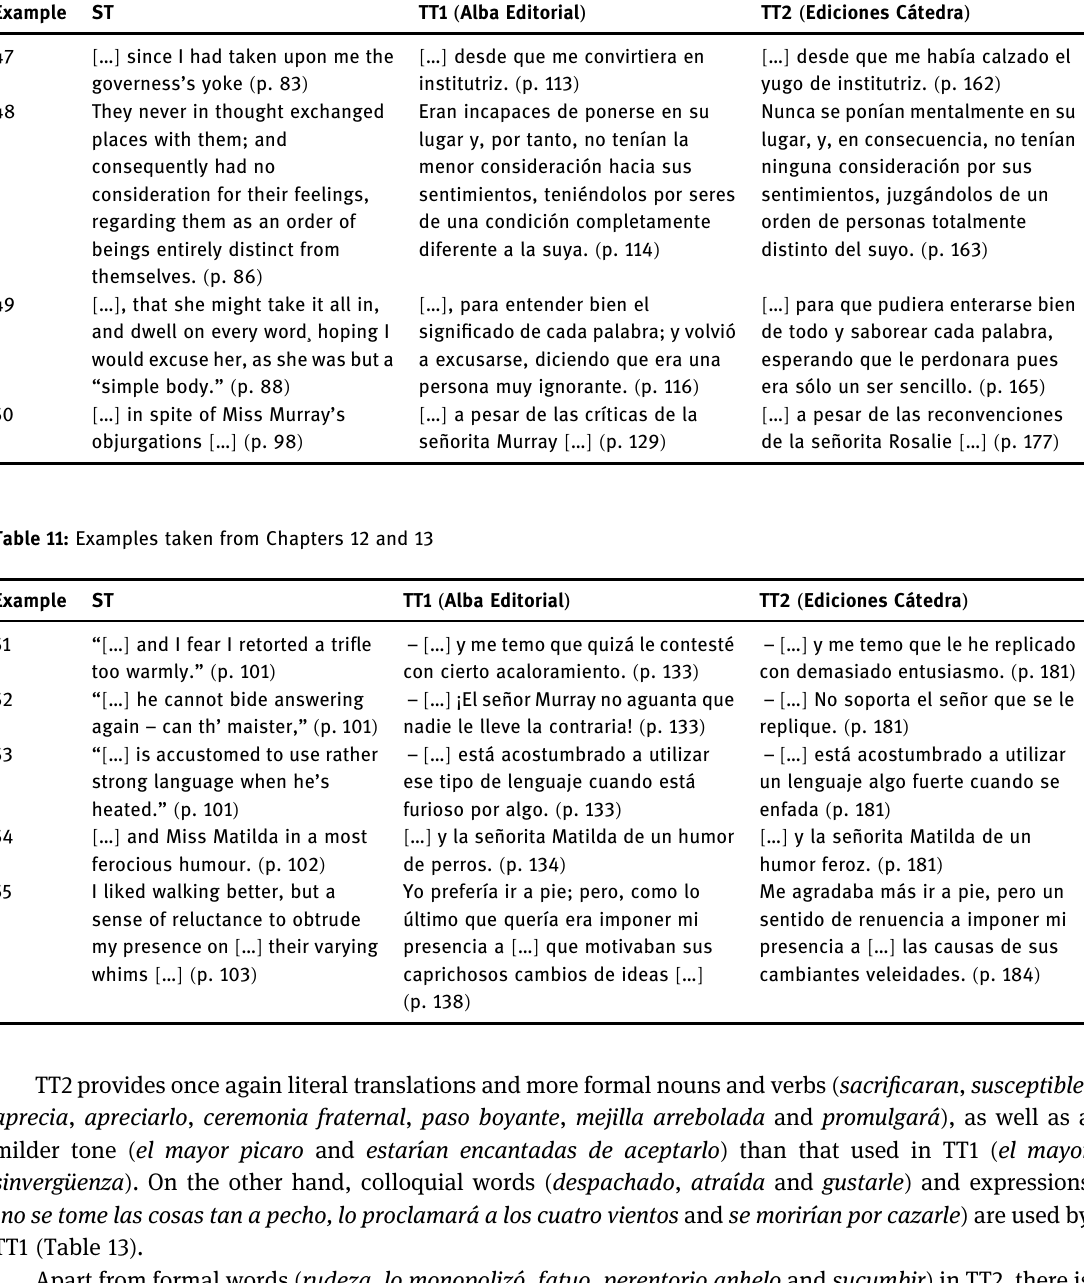
Table 10: Examples taken from Chapter 11 Example